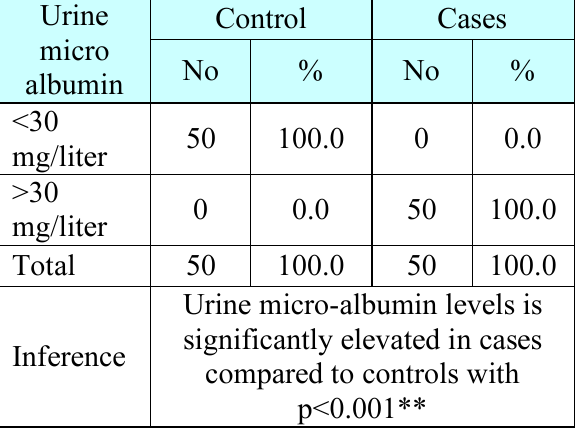
Table 4: Shows the comparison of Mean values of urine microalbumin in two groups